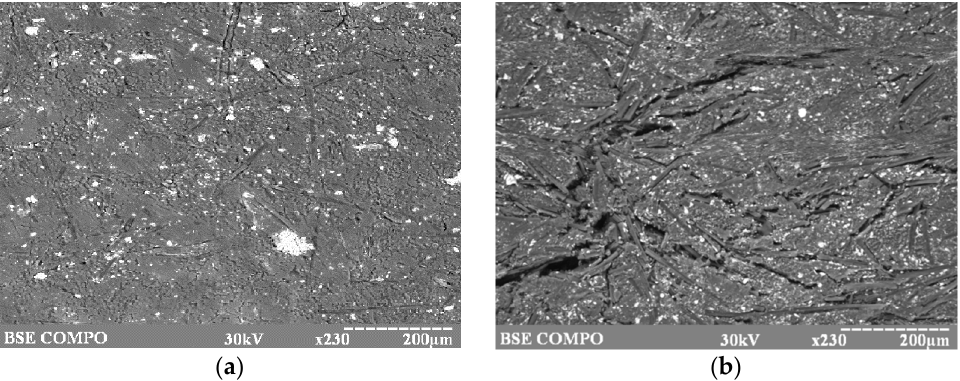
Figure 6. Electron photomicrographs of CFRP F4CF20 before ( a ) and after ( b ) exposition to water (×230).